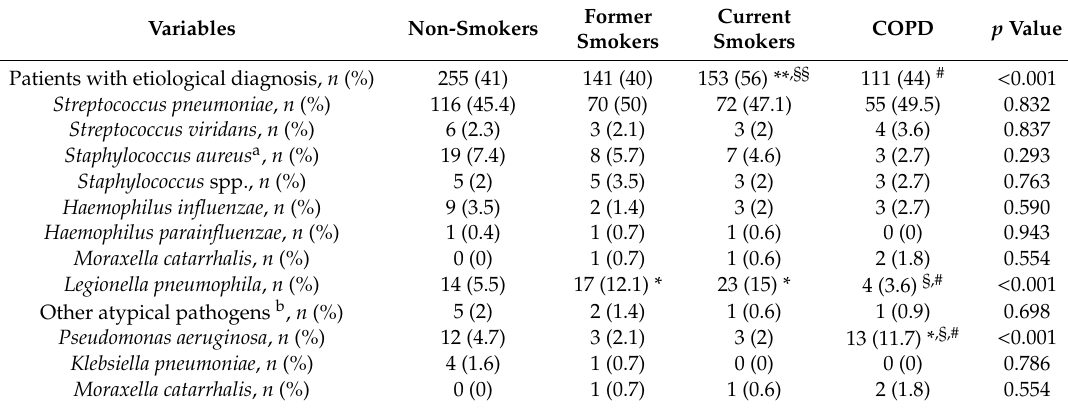
Table 3. Microbiological variables by smoking habit and COPD